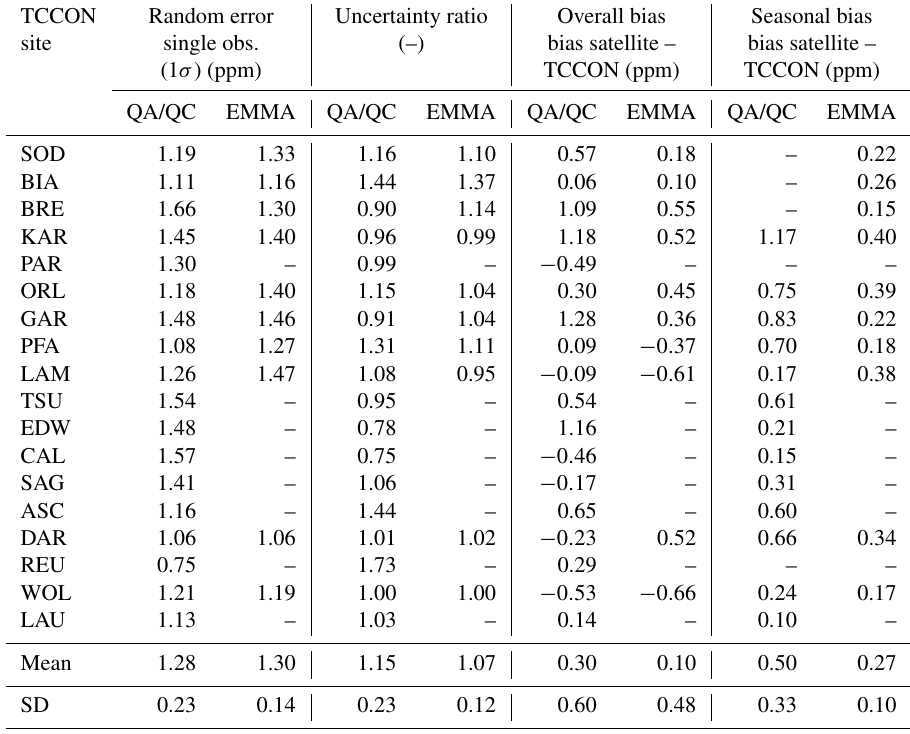
Table 4. Overview validation results at TCCON sites for data product XCO2_EMMA (version 4.1). TCCON